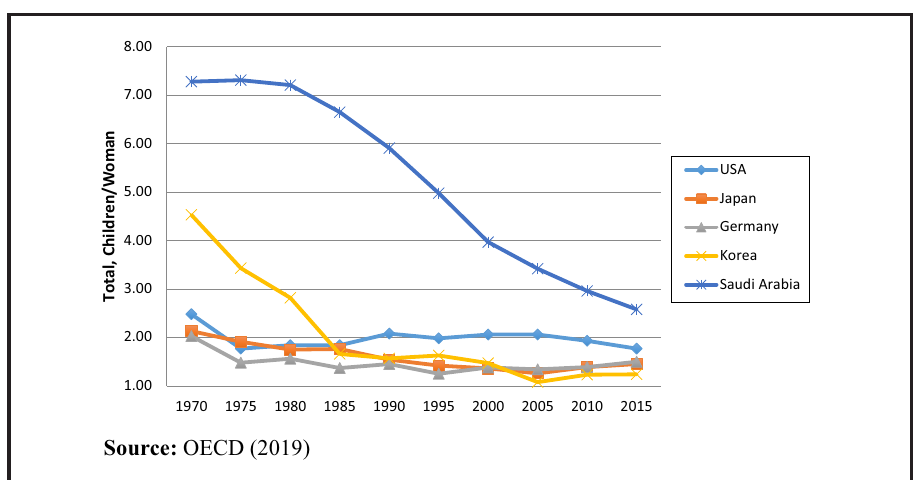
Table I Solutions to the demographic crisis Solution